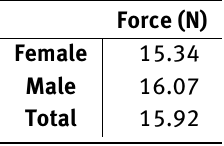
Table 5: Average sum of sensor forces of user choice.